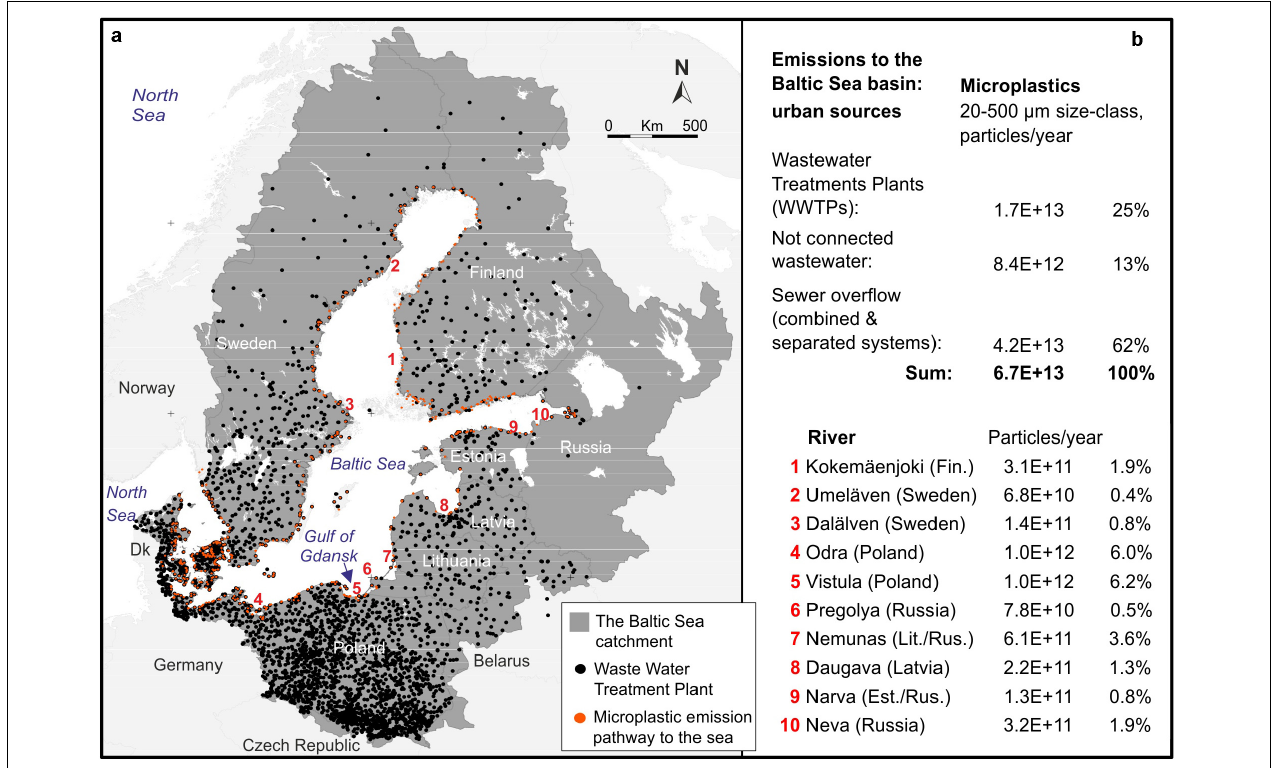
FIGURE 1 | (a) Location of the 3525 wastewater treatment plants in the Baltic Sea catchment (black dots), micro-plastics emission points (rivers and direct discharge) to the Baltic Sea, including Kattegatt (red dots), and location of 10 selected rivers (red numbers). (b) total micro-plastic (floating and sinking fraction, size class 20–500 µ m) emissions to the Baltic Sea from all three urban sources and emissions from selected rivers as well as the share of every river of the total